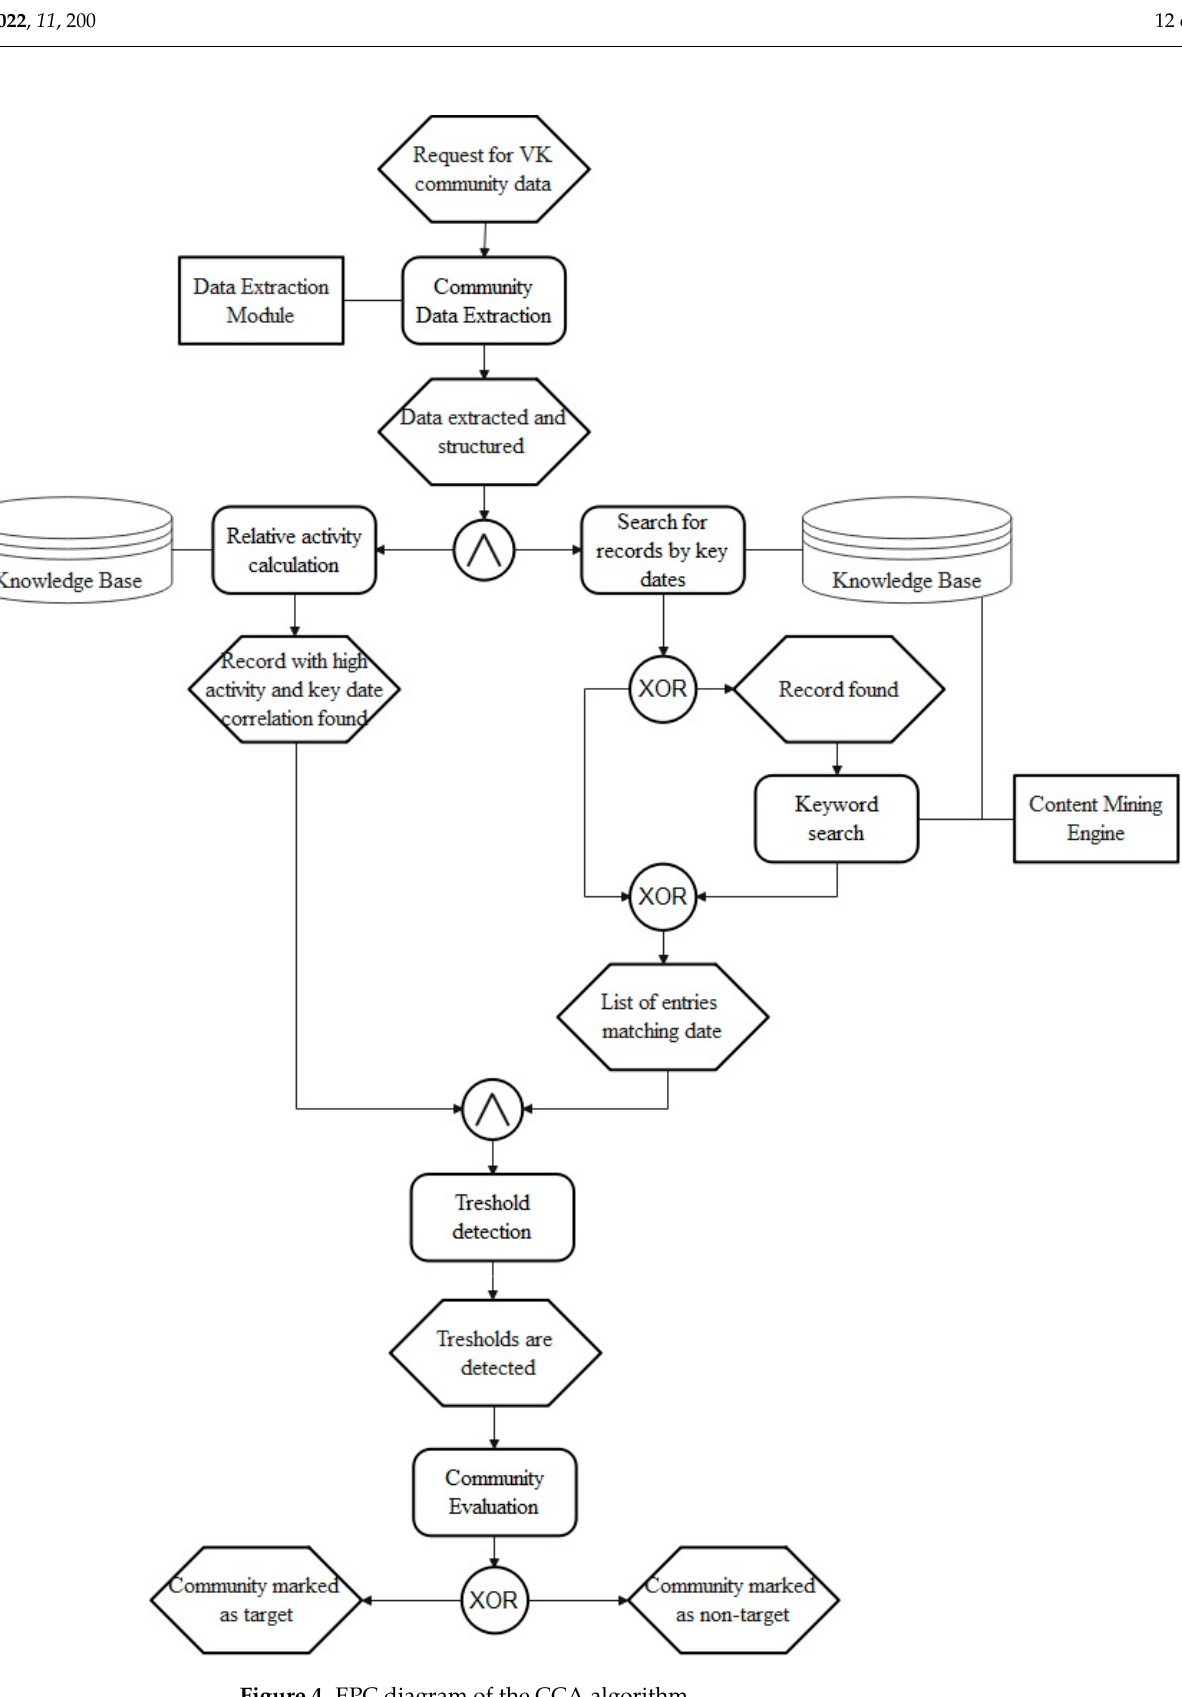
Figure 4. EPC diagram of the CCA algorithm.